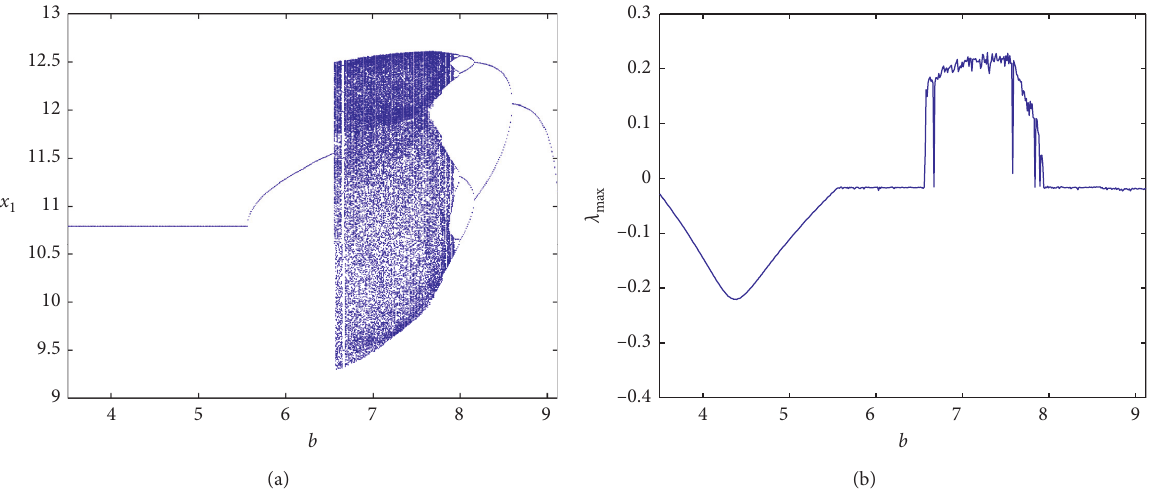
Figure 7: (a) Bifurcation diagram showing local maxima of the coordinate x exponent ( λ ) plotted by decreasing b in the range 3 . 5 ≤ b ≤ 9 . 12, with a � 1 . 8, m � 3, c � 2 . 442, d � 1 . 35, and e � 15 and initial conditions max ( x